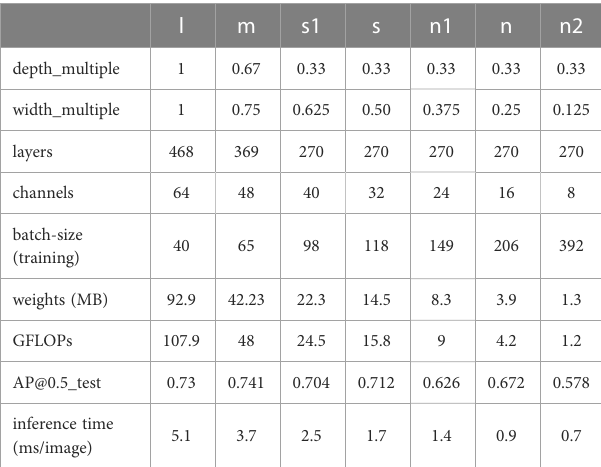
TABLE 3 The ablation study of YOLOv5n with and without activations